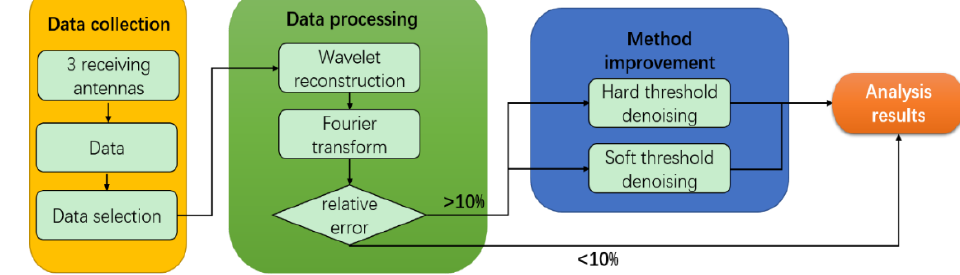
Figure 1. The logic flow of our system.